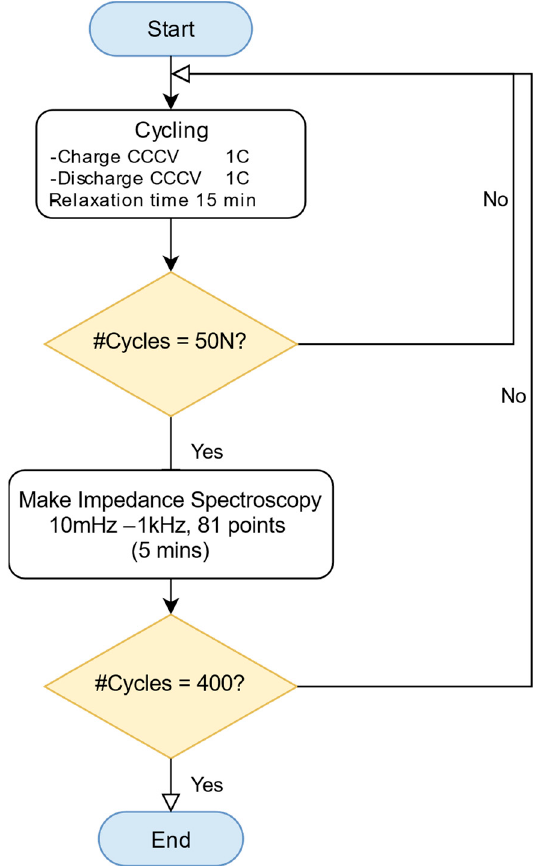
Figure 5. Flowchart of the cycling and measurement procedure.